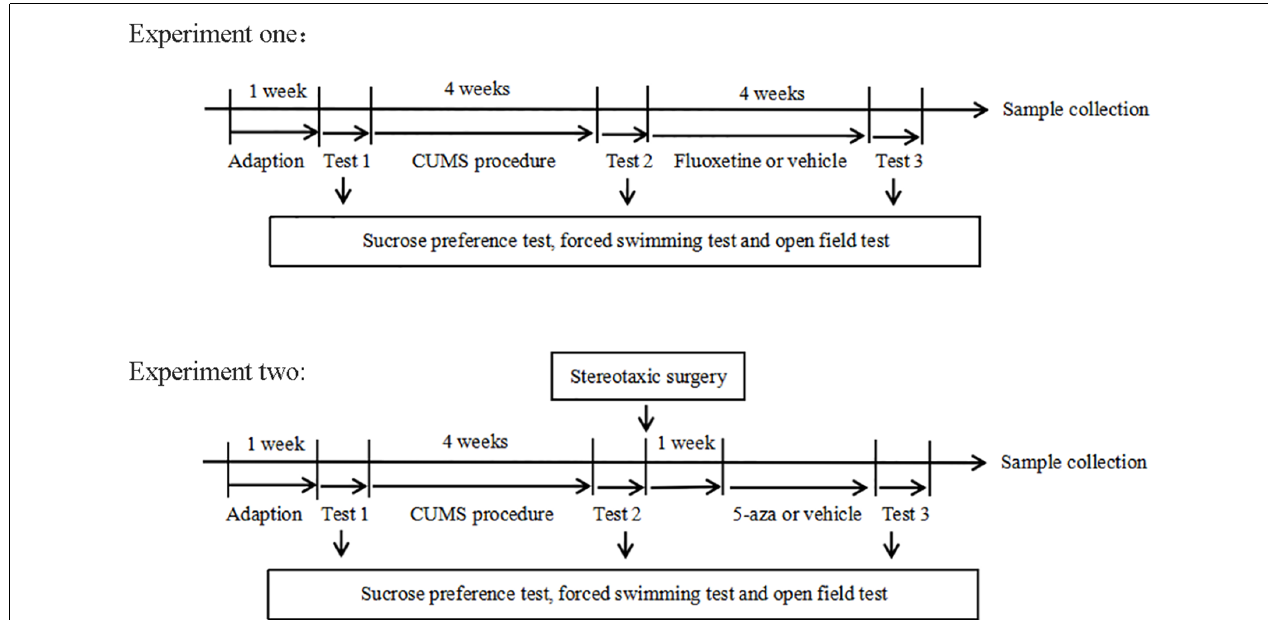
FIGURE 1 | Experimental